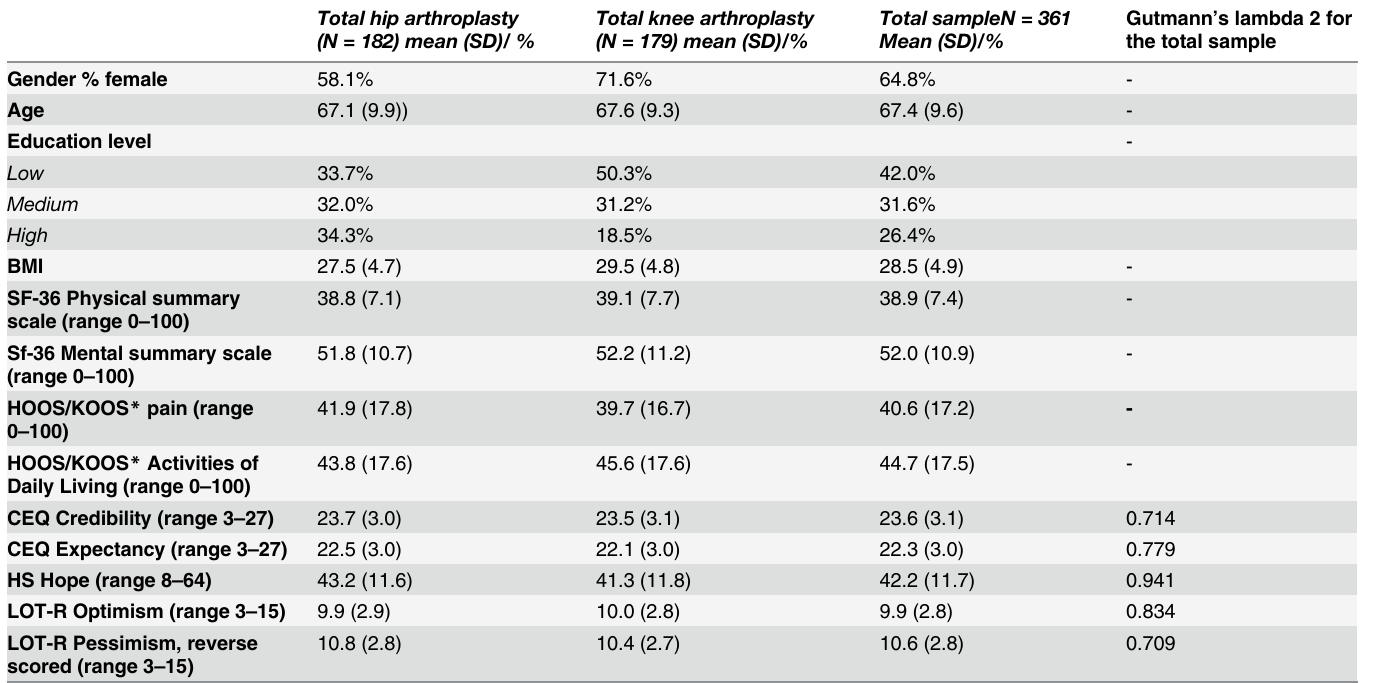
Table 2. Characteristics of the sample included in this study and lambda 2 values for the subscales included in the Confirmatory Factor Analysis. Total hip arthroplasty (N = 182) mean (SD)/ %